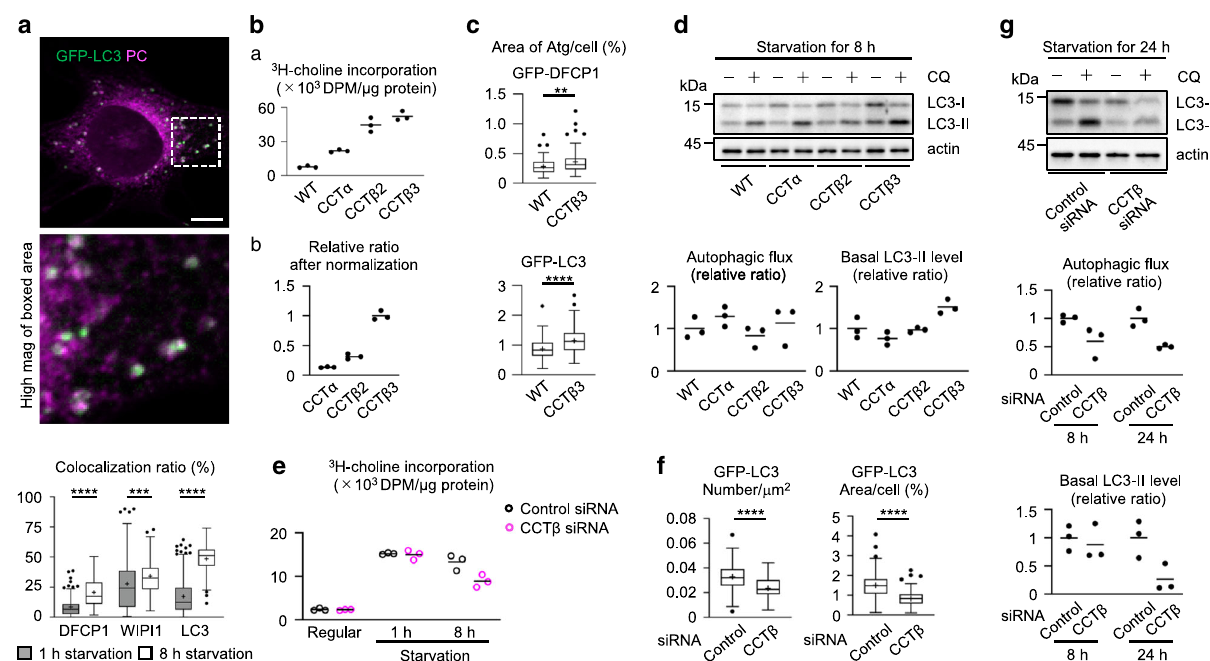
Fig. 4 PC and CCT isoforms in MEFs starved for 8 – 24 h. a Colocalization of de novo-synthesized PC (magenta) and GFP-tagged Atg proteins